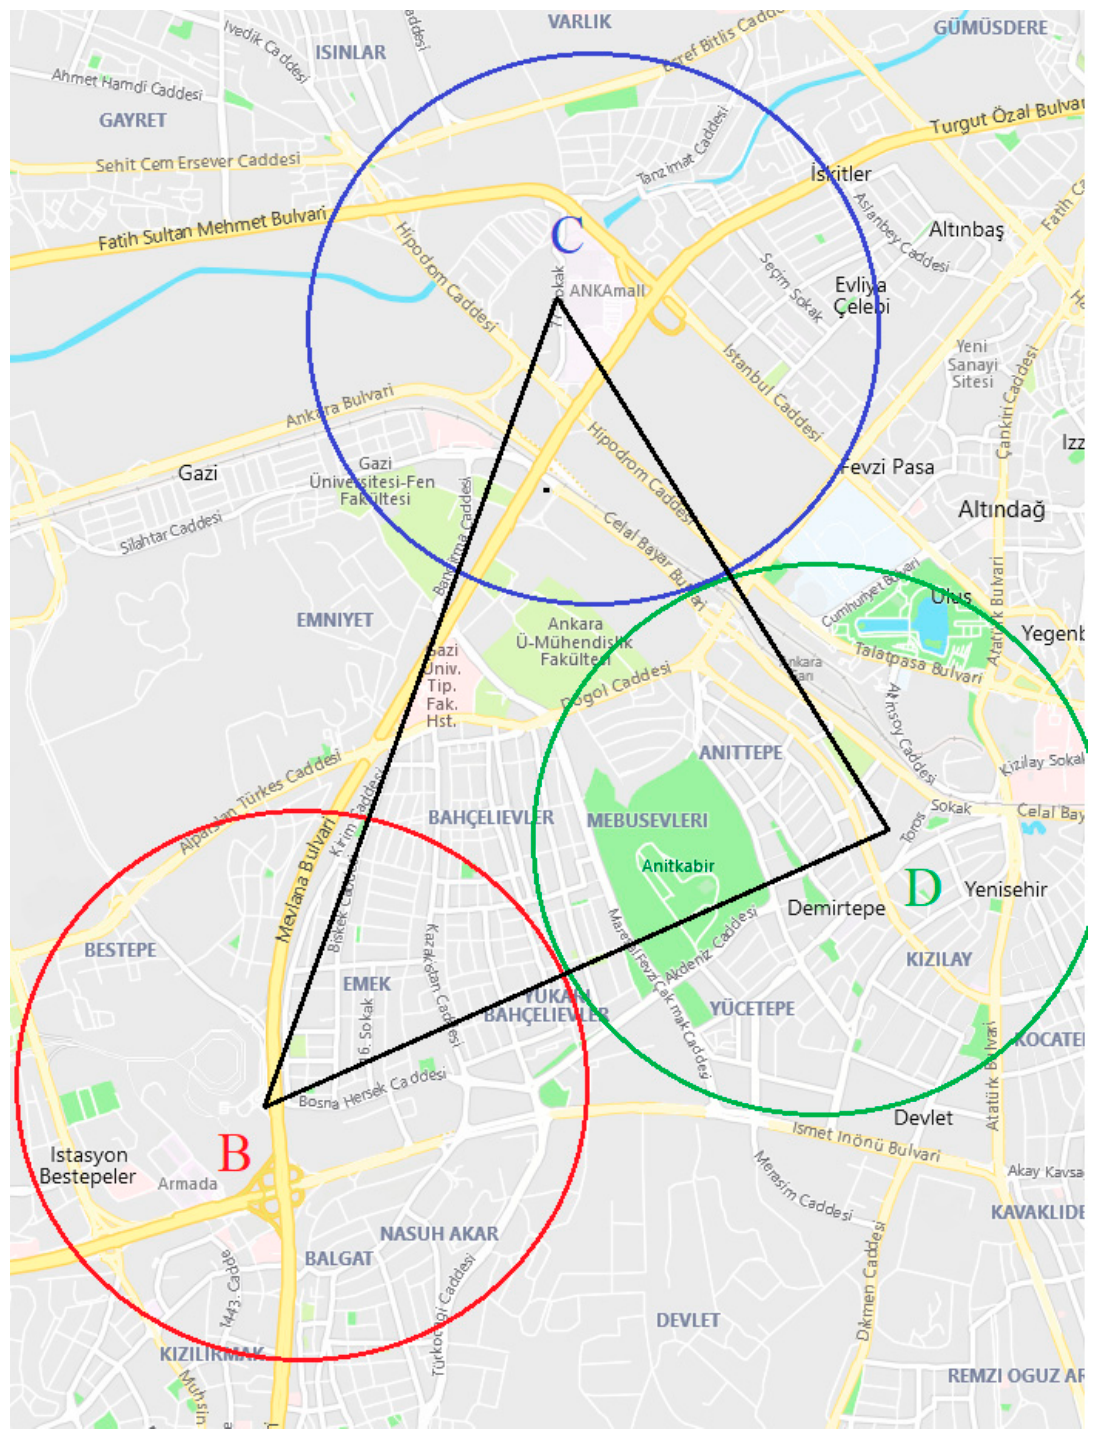
Figure 12. Selected points in Ankara (By Bing map).